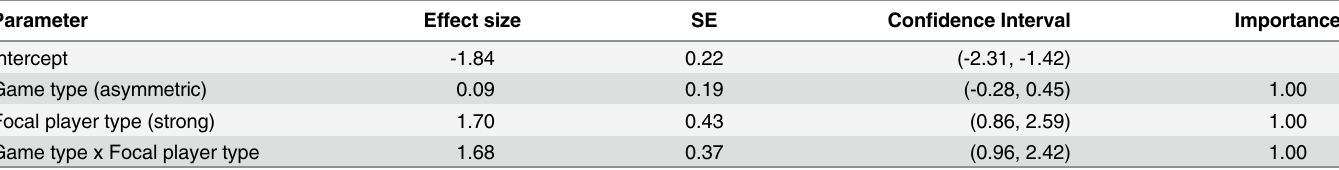
Table 4. Factors affecting whether players punished their partners.